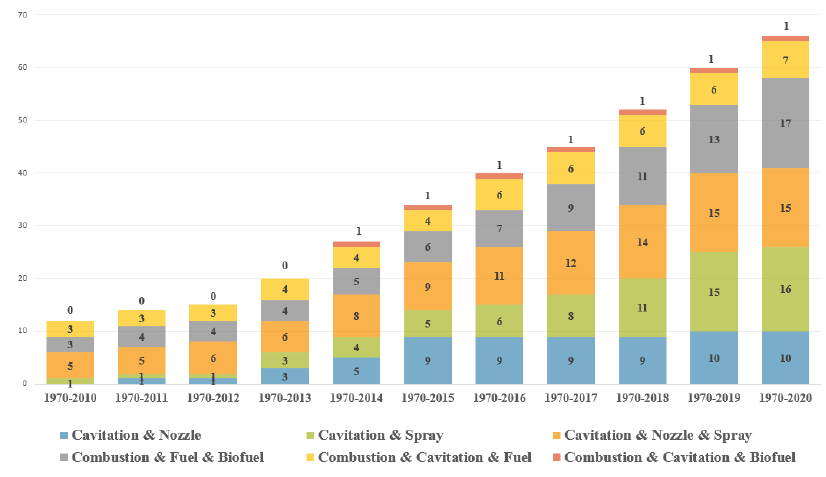
Figure 6. Relevant articles in the different subgroups in the last decade.